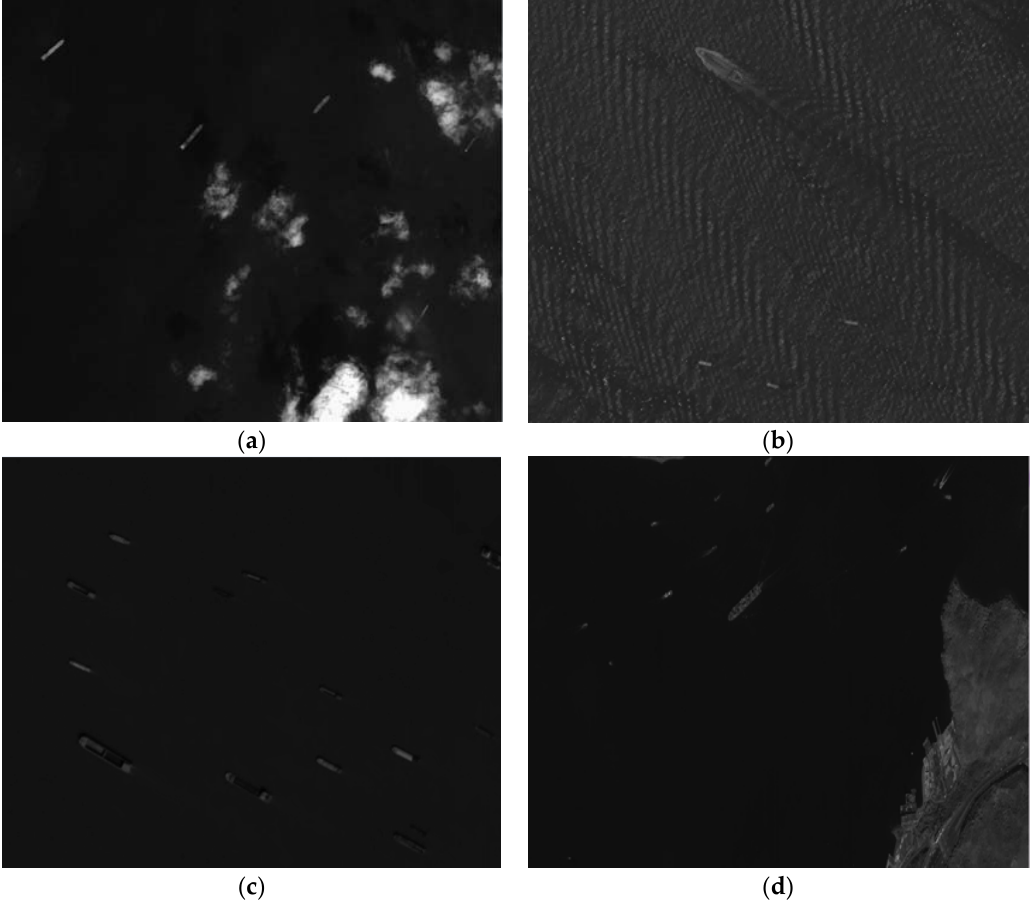
Figure 16. Examples of different sea surfaces. ( a ) Cloud coverage; ( b ) visible swell; ( c ) low contrast; and ( d ) simple sea.